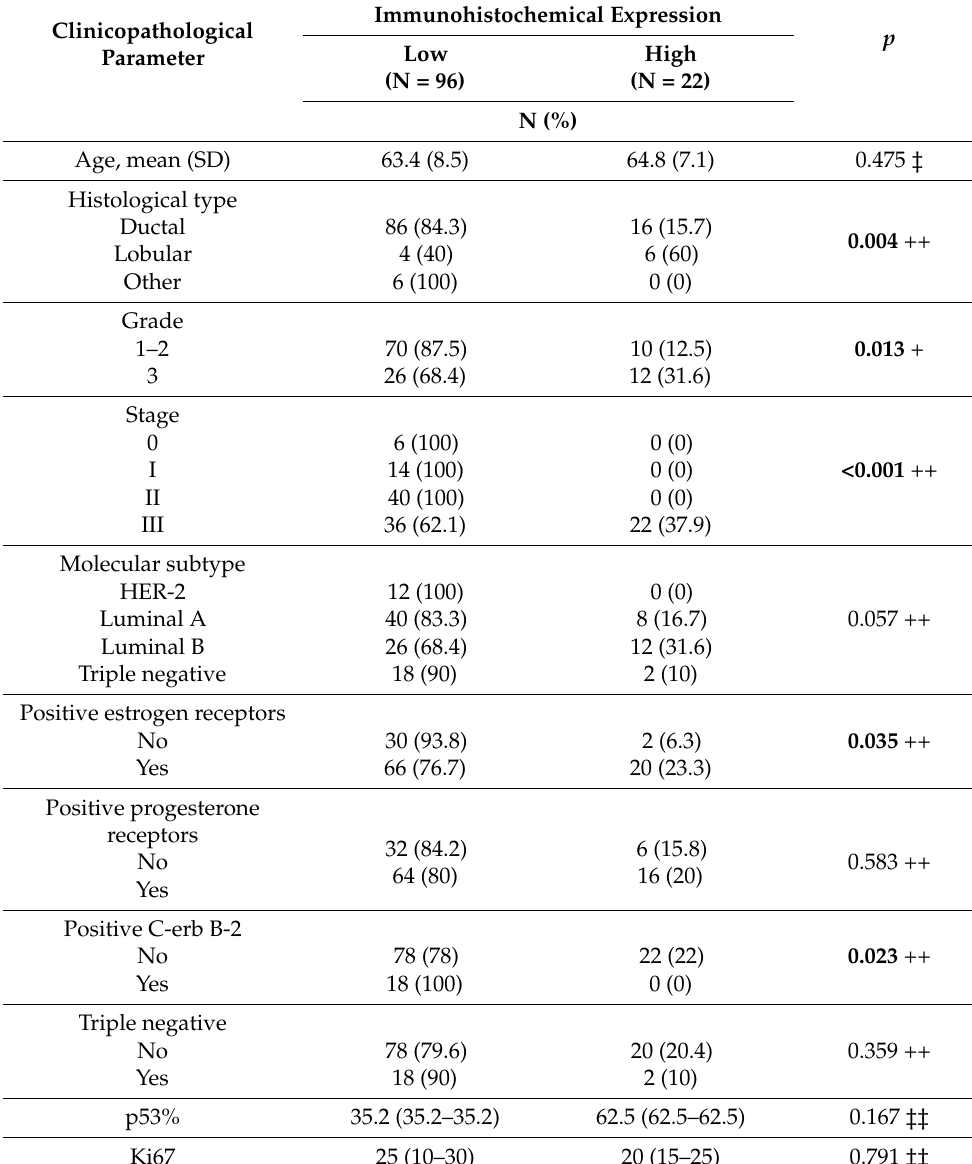
Table 2. Correlation of immunohistochemical expression with demographics and clinical characteris-